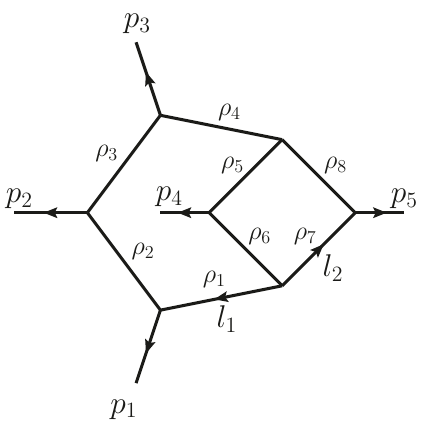
Figure 1 . The nonplanar hexa-box topology. We consider the case with all external and internal lines